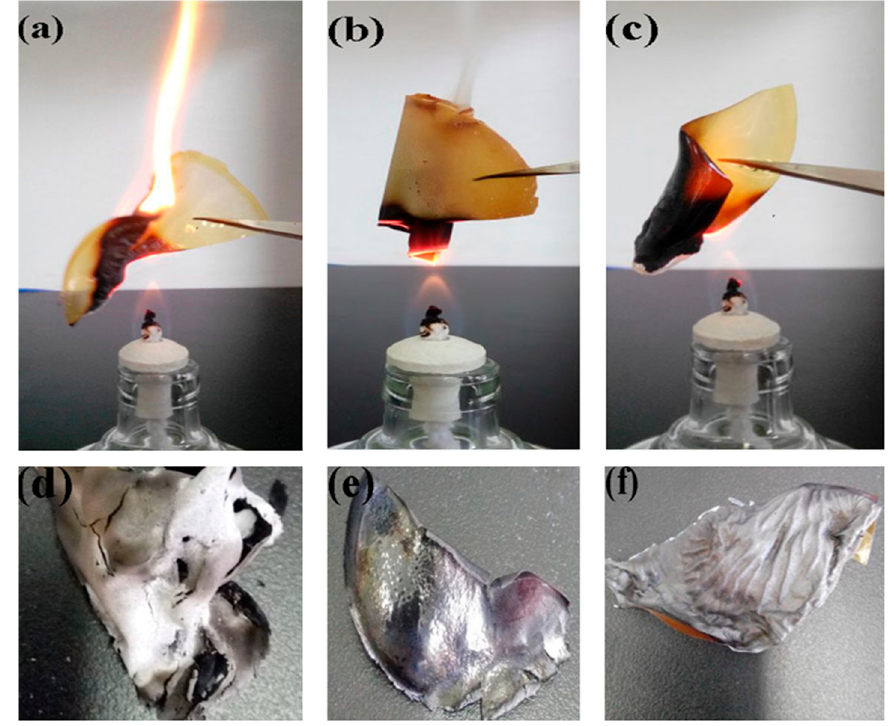
Figure 10. The burning and burned pictures of pure CS ( a , d ), CS/MAG ( b , e ), CS/KH550/MAG ( c , f ) hybrid membranes.